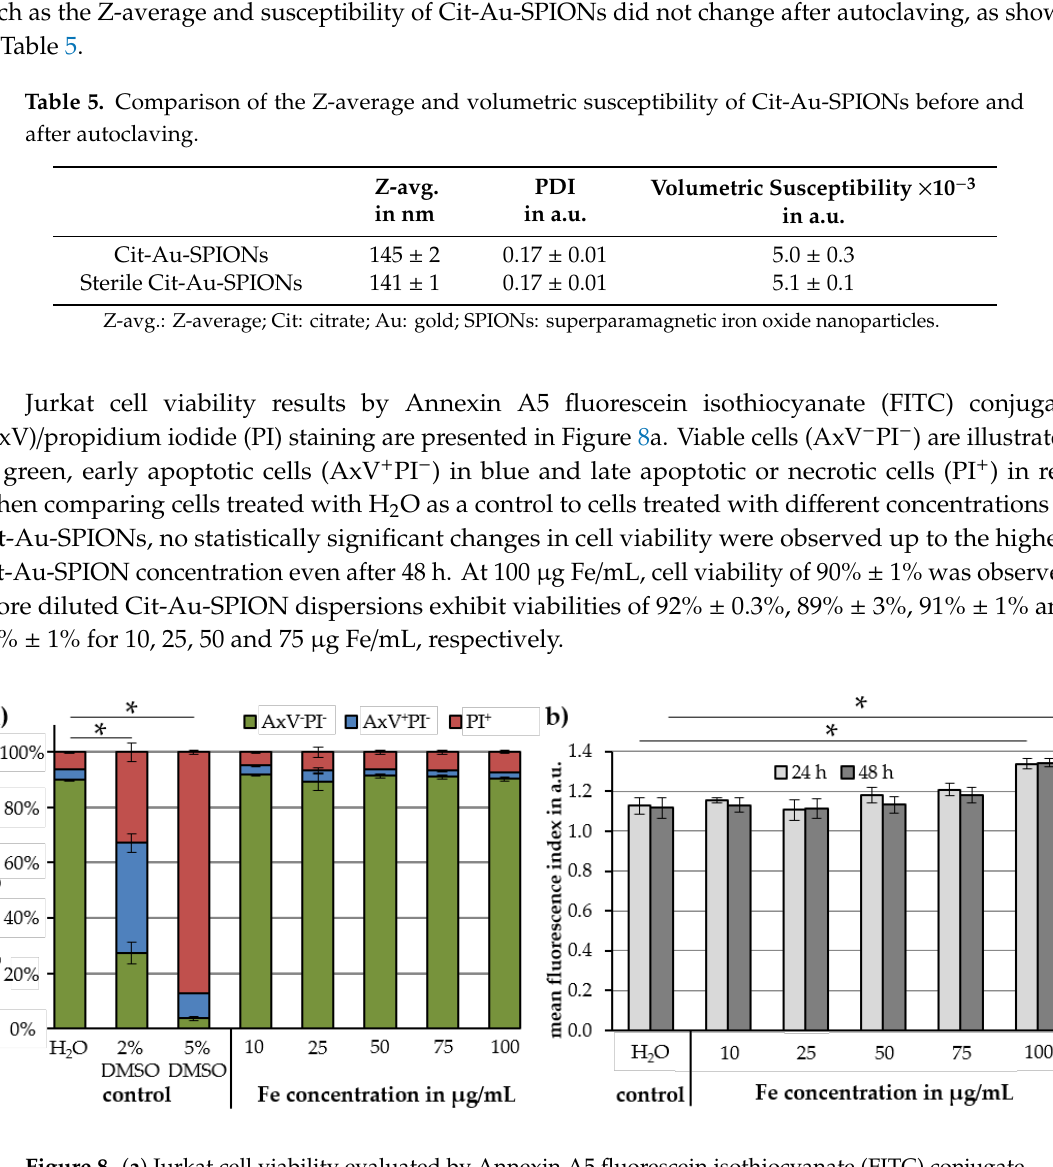
Figure 8. ( a ) Jurkat cell viability evaluated by Annexin A5 fluorescein isothiocyanate (FITC) conjugate (AxV)/propidium iodide (PI) staining after 48 h of incubation with different Cit-Au-SPION concentrations and ( b ) Cit-Au-SPION uptake into Jurkat cells evaluated by Lucifer Yellow staining after 24 and 48 h of incubation with different concentrations of Cit-Au-SPIONs. Statistically significant changes are marked with * for p < 0.05.